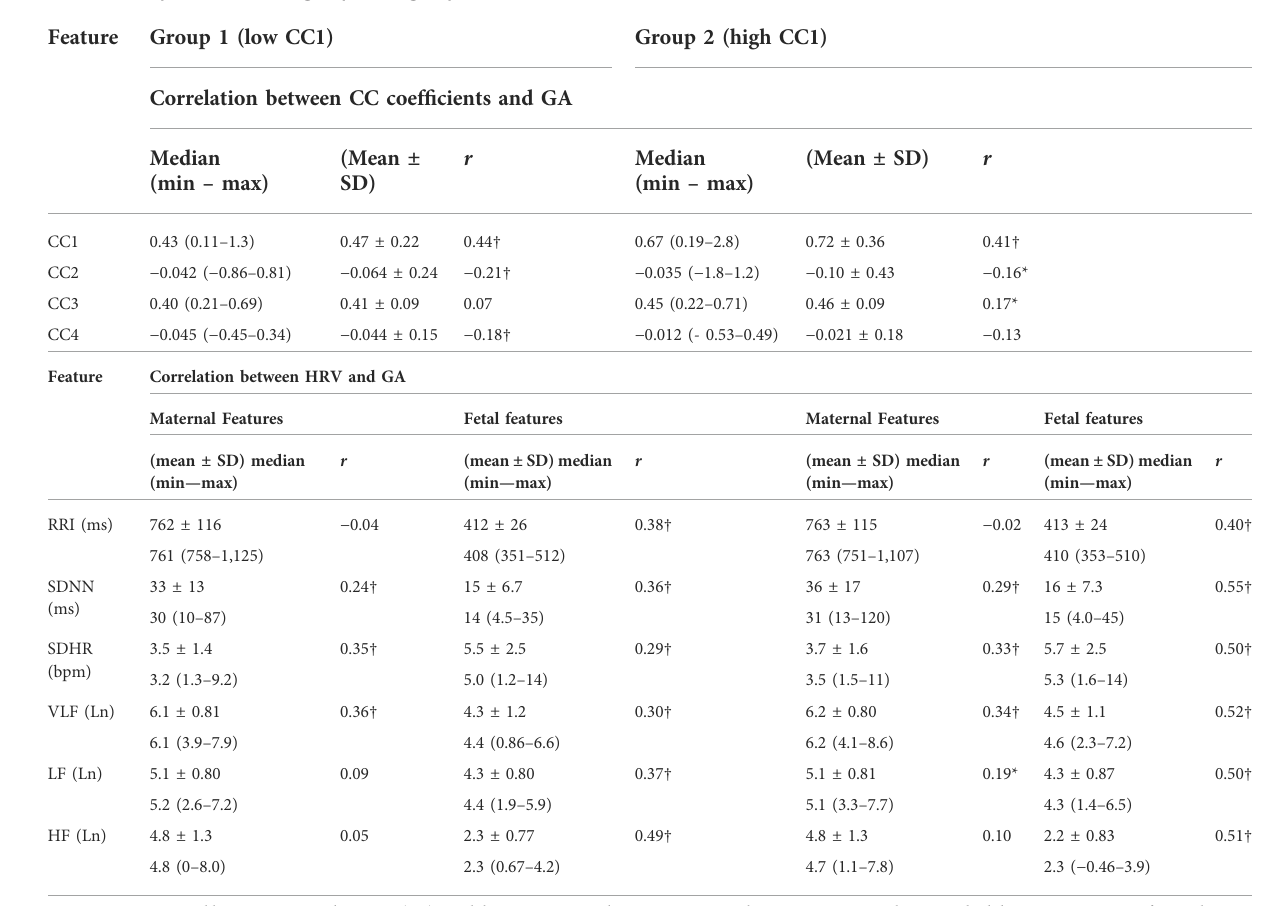
TABLE 2 Comparison between group 1 and group 2 in terms of HRV and CC association with GA, n =